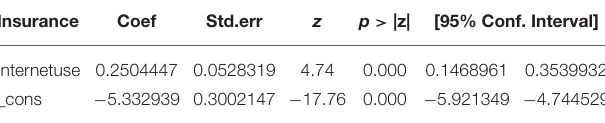
TABLE 6 | The relationship between residents’ health and commercial insurance.